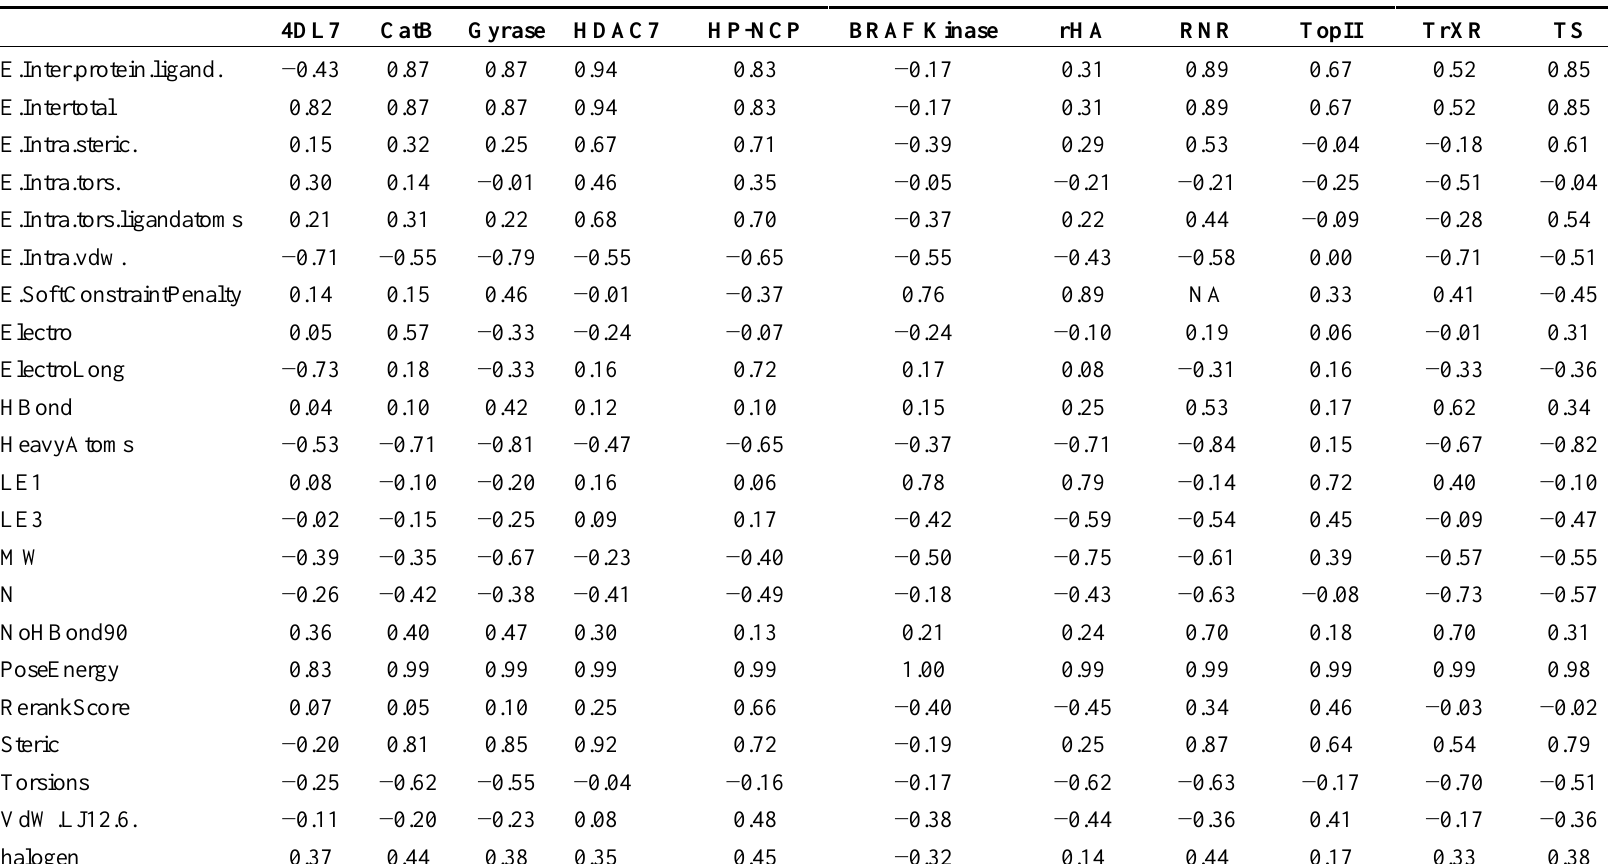
Table 9. The correlation of the factors that determine the binding interaction of the metallocompounds with the receptors using Molgro docking (constrained docking) 4DL7 CatB